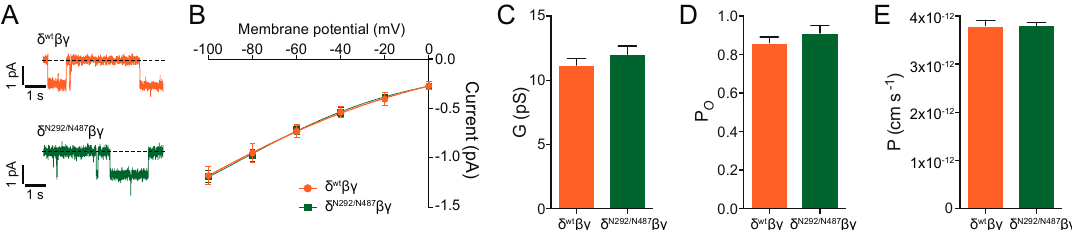
Figure 5. Single-channel properties of construct N292/N487 expressed with β and γ are comparable to wild type δβγ ENaC. ( A ) Patch-clamp recording in the cell-attached configuration. ( B ) The current-voltage relationship is similar between wt and N292/N487. Single-channel conductance (G, panel C ), open probability (P O , panel D ) and permeability (P, panel E ) were comparable between δ wt βγ ENaC and δ N292/N487 βγ (n ≥ 7, unpaired t -test).